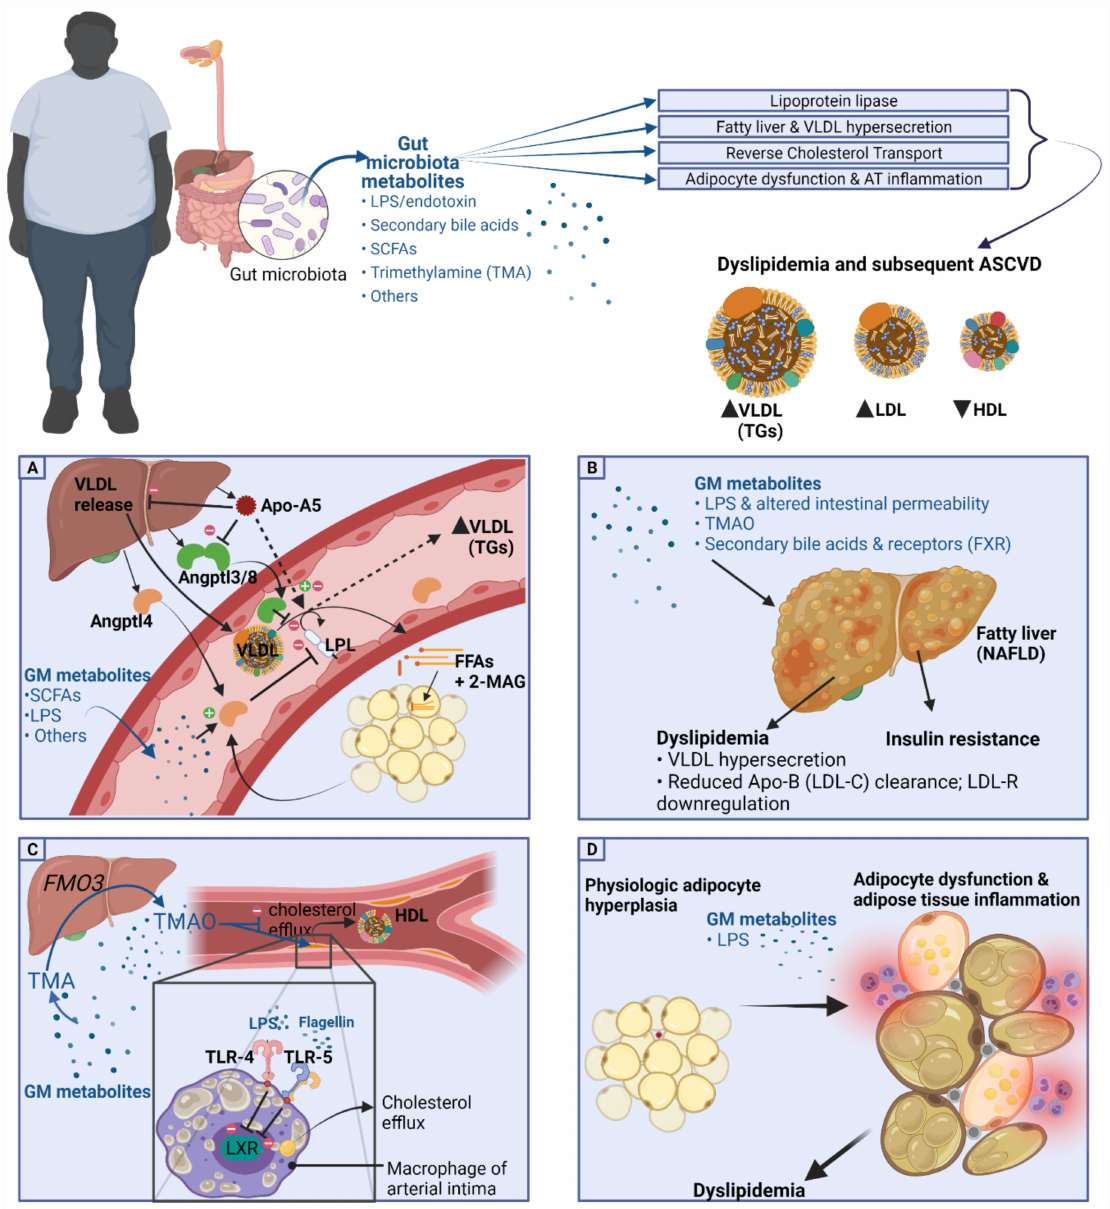
Figure 2. Gut microbiota and its metabolites in dyslipidemia. GM-produced metabolites have been associated with alterations of lipoprotein lipase function, fatty liver disease (NAFLD), inhibition of reverse cholesterol transport (RCT),